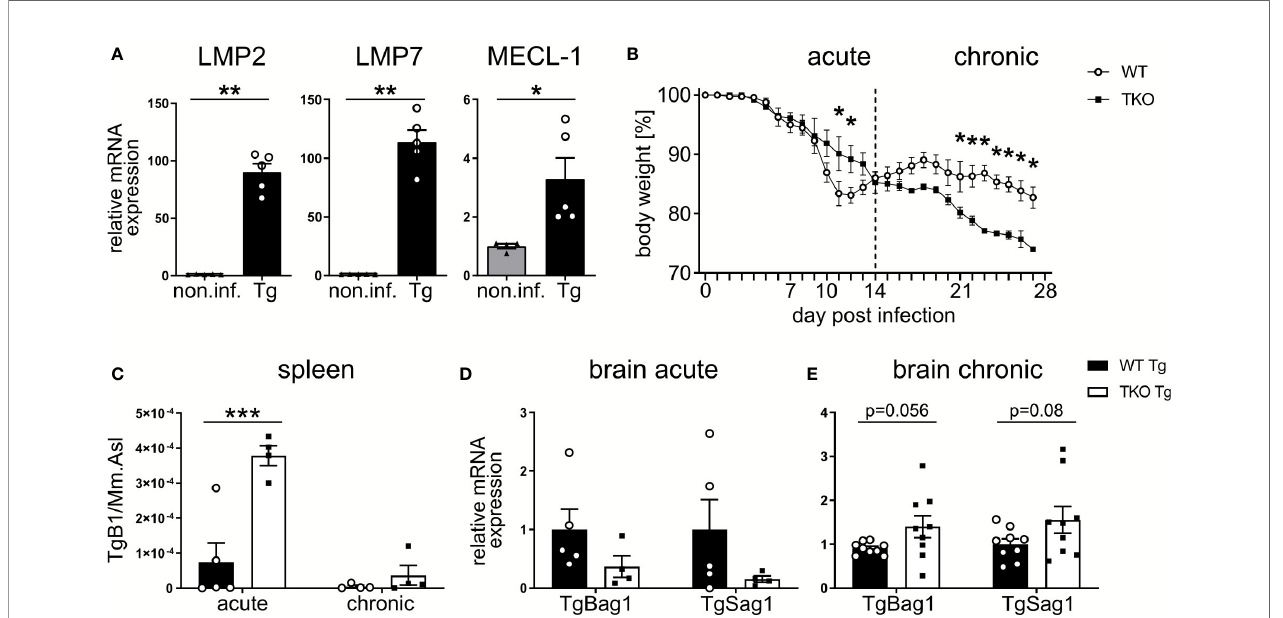
FIGURE 1 | Increased susceptibility of TKO mice in the chronic, but not acute, phase of T. gondii infection. Wild type (WT) mice were orally infected with a low dose (2 cysts) of T. gondii (ME49) for 28 days. Brains were collected from WT non-infected (non.inf., n ≥ 4) and T. gondii infected (Tg, n ≥ 4) animals on day 28 p.i. and following homogenization, mRNA was extracted for RT-qPCR analysis. (A) mRNA expression of the immunoproteasome subunits (LMP7/ Psmb8 , LMP2/ Psmb9 , MECL-1/ Psmb10 ) were normalized to the non-infected group. Data is representative of four independent experiments. (B) WT mice and triple-knocked out (TKO) for the immunoproteasome subunits (LMP7/Psmb8 -/- LMP2/Psmb9 -/- MECL-1/Psmb10 -/- ) mice were orally infected with a low dose (2 cysts) of T. gondii and weighed daily. Day 10 and 28 p.i. were chosen as time points for the acute and chronic immune response. The spleens and brains were taken from acute (d10 p.i. ) and chronic (d28 p.i. ) T. gondii -infected WT (WT Tg, n=4) and triple-knockout (TKO Tg, n=4) mice. Organs were homogenized and DNA/RNA was isolated from each for qPCR and RT-qPCR analysis. (C) qPCR analysis from DNA extracted from spleens of T. gondii infected WT and TKO mice. Relative quanti fi cation of T. gondii gene TgB1 in spleen from acute (d10 p.i. ) and chronic (d28 p.i. ) T. gondii infected WT and TKO mice. TgB1 gene expression was normalized to the gene expression of the reference gene Mm.Asl . (D, E) RT-qPCR analysis from RNA extracted from brain homogenates of mice from the acute (d10 p.i. ) and chronic (d28 p.i. ) phase of infection. Relative mRNA levels were normalized to the mean expression of the infected WT group. Data shown in (A) represents three independent experiments and data shown in (B – E) represent four independent experiments. In (A, C – E) symbols represent individual animals, columns represent mean values and error bars represent ± SEM. In (B) , data points represent mean values and error bars represent ± SEM. In (A) , a Mann-Whitney test for two groups and in (B – E) a 2way ANOVA following Fisher ’ s LSD test was used for statistical analysis. *P < 0.05, **P < 0.01, ***P <